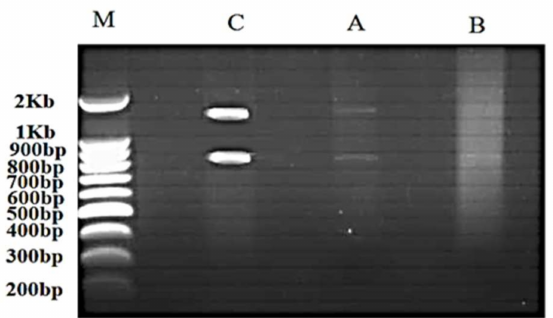
Figure 7. Gel electrophoresis of RNA extracted from Chlorella vulgaris . Extracted RNA from: untreated sample with silver nitrate (control C), C. vulgaris incubated with silver nitrate for one hour (A), C. vulgaris incubated with silver nitrate for four hours with smear formation (B); (M), molecular size marker.